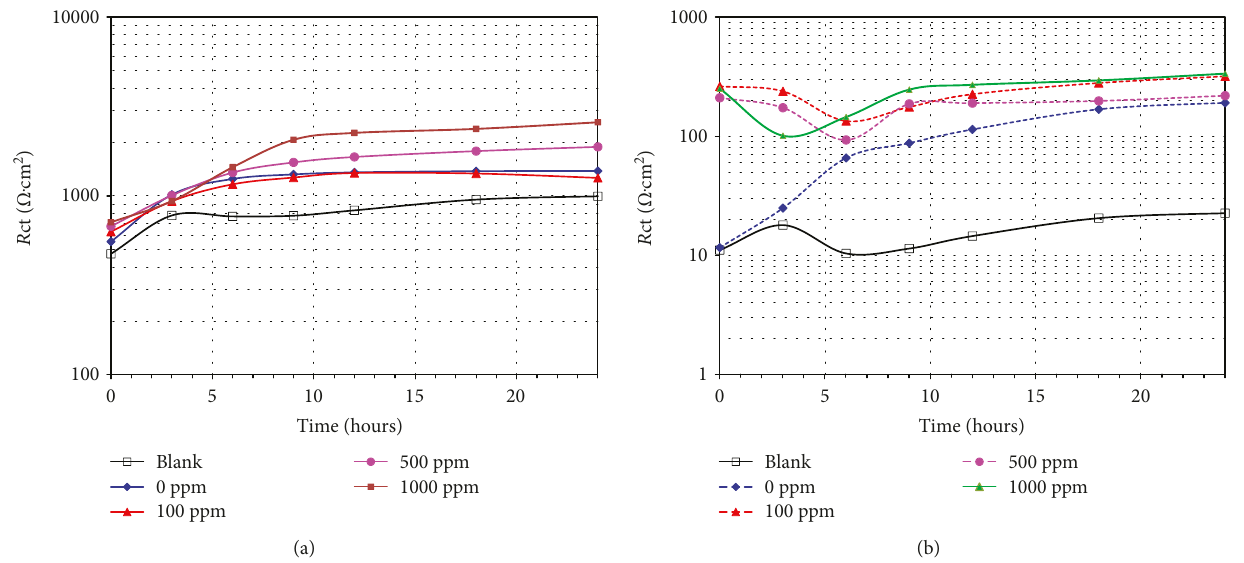
Figure 13: Evolution of the (a) R concentrations of nanoparticles.